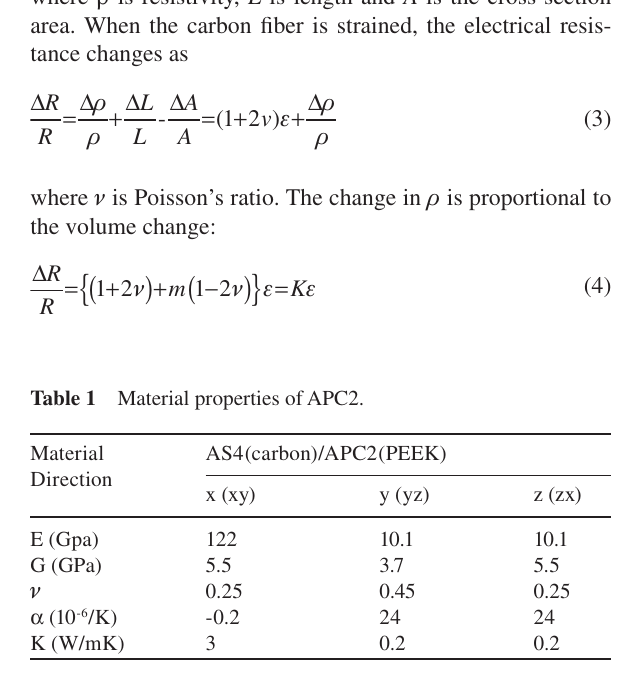
Table 2 Measured electrical conductivity ratio of